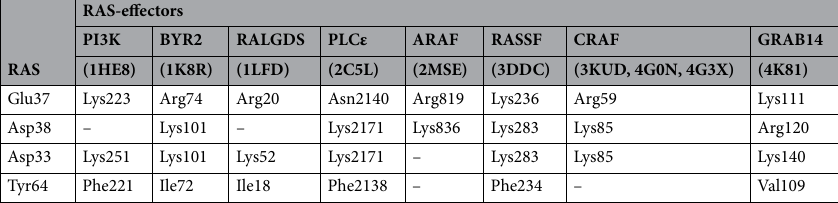
Table 1. Intramolecular contacts conserved among RAS-effectors